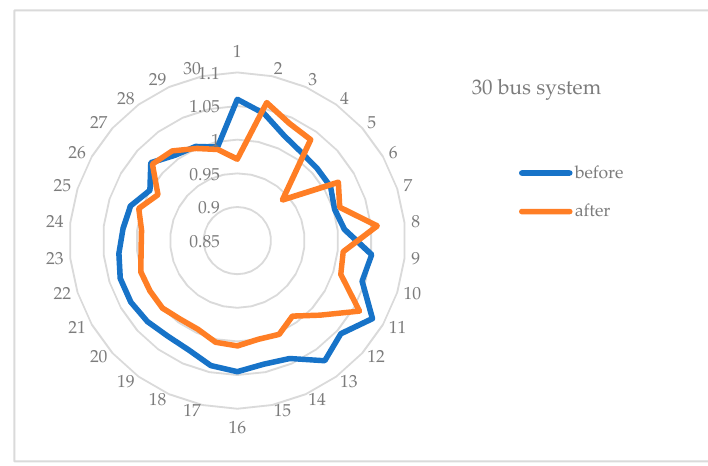
Figure 6. Bus voltages of the 30-bus system before and after ORPD.